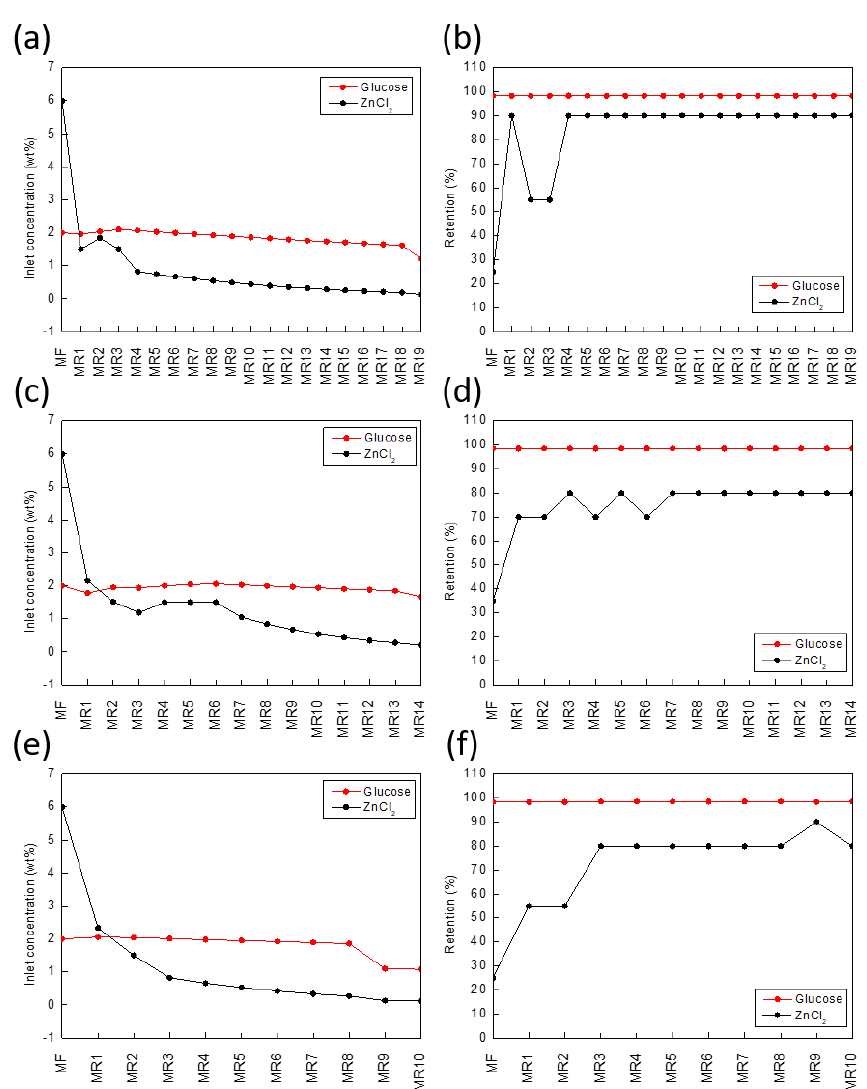
Figure 4. Variations of inlet concentration and retention in MF and MR units: ( a ) inlet concentration for scenario 1; ( b ) retention for scenario 1; ( c ) inlet concentration for scenario 2; ( d ) retention for scenario 2; ( e ) inlet concentration for scenario 3; ( f ) retention for scenario 3. Table 3. Selection of membrane types for scenario 3.